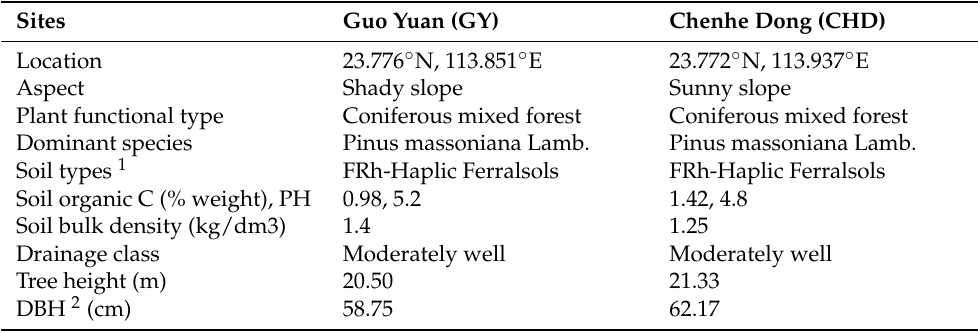
Table 1. The information of the environmental characteristics for these two